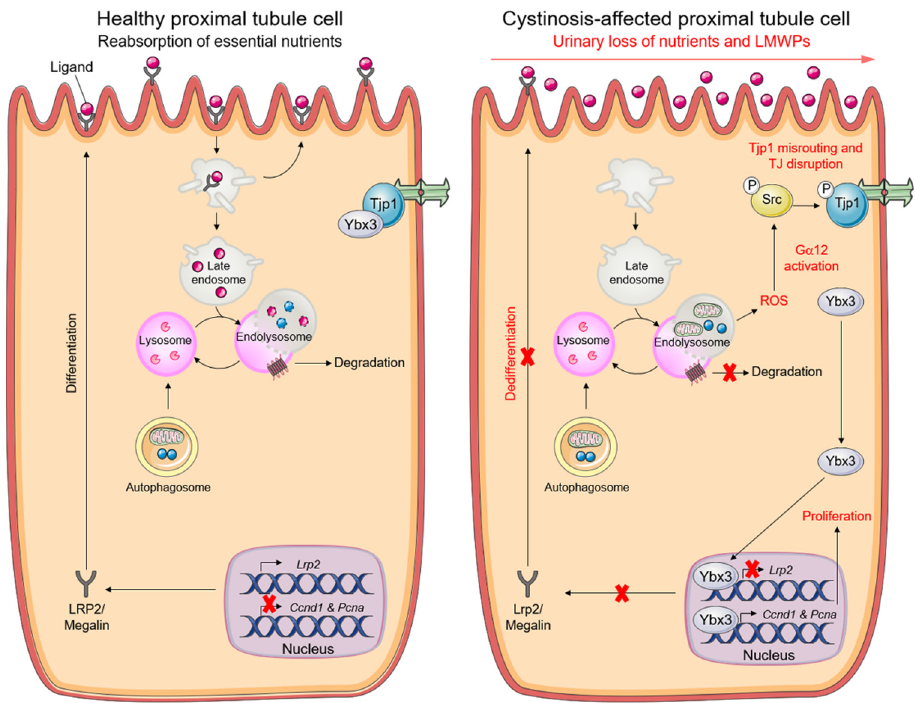
Figure 4. Pathogenic cascade driving PT dysfunction in cystinosis cells. Graphical schematic illustrating that cystinosin-deficient PT cells accumulate dysfunctional mitochondria and reactive-oxygen species (ROS), triggering an abnormal activation of the tight junction—associated signalling that stimulates proliferation while suppressing apical dedifferentiation. Reprinted with permission from Ref. [6]. Copyright 2021 Springer Nature.